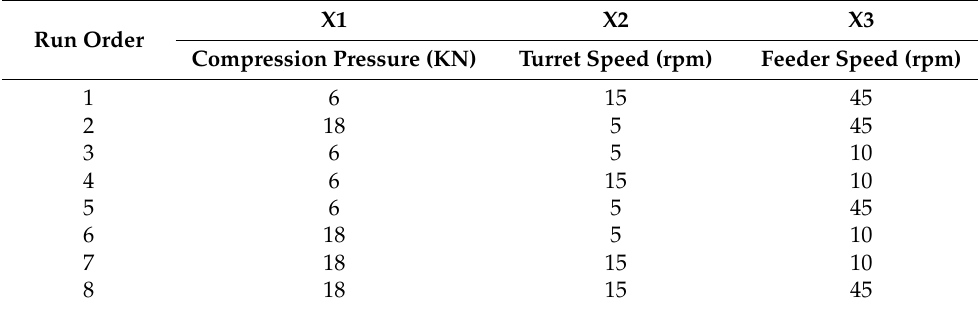
Table 2. Conditions of the tableting process as planned using the DoE. X1 X2 X3 Run Order Turret Speed